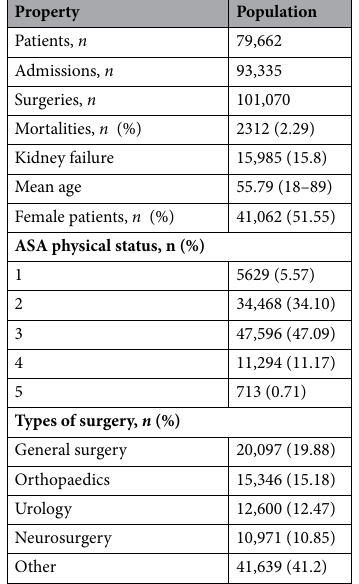
Table 1. Patient characteristics. Patient characteristics for the cohort used for training and testing models. Number of patients and percent of the cohort are shown. The selected surgical services represent the top four most frequent surgical services.